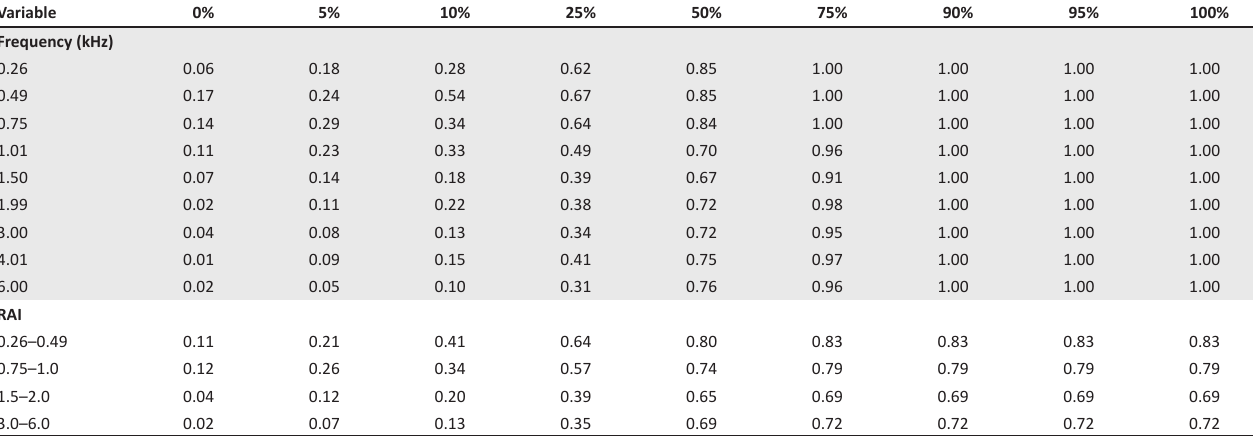
TABLE 2: Mean reflectance and RAI values for 0.26 kHz – 6 kHz for NICU neonates by using tone stimuli ( n = 82 ears).